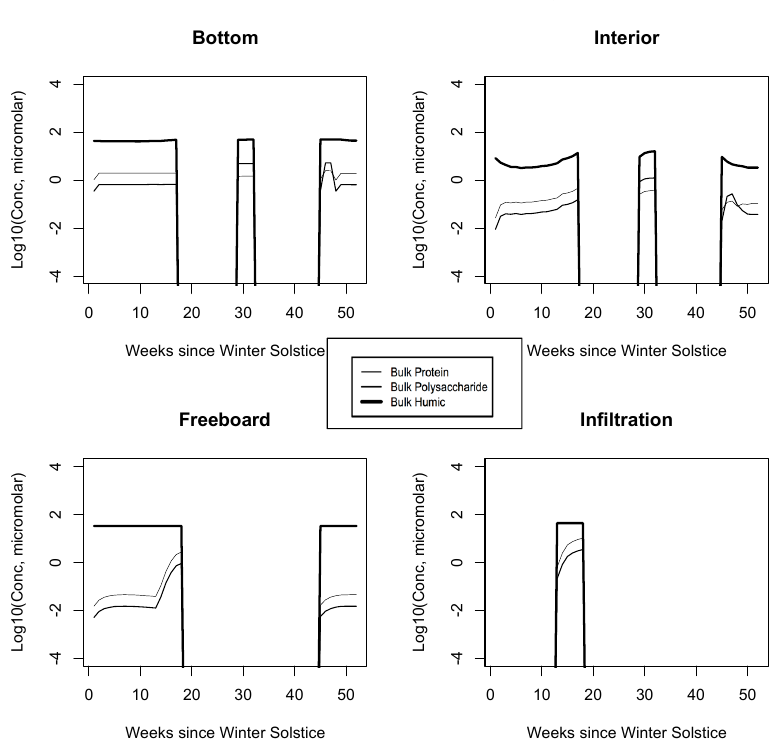
Figure 7. Sea of Okhotsk. Time evolution for bulk organic concentrations from the baseline run, for the four habitat levels. Values are base 10 logarithms for carbon in micromolar. Lipid profiles closely follow proteins or polysaccharides and for simplicity are not shown.